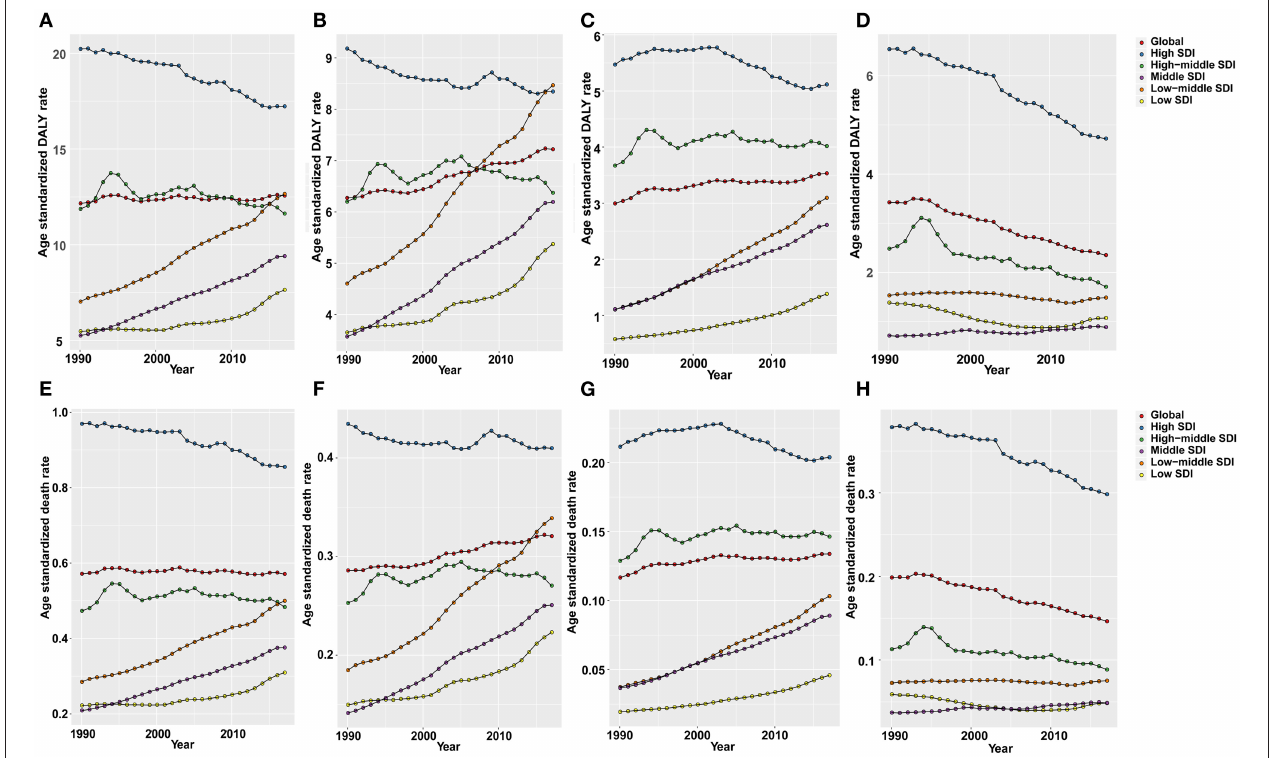
FIGURE 5 | The age-standardized rates of DALYs and deaths (per 100,000) attributable to all risks (A,E) , high fasting plasma glucose (B,F) , high body mass index (BMI) (C,G) , and occupational exposure to asbestos (D,H) globally and in all SDI quintiles from 1990 to 2017.